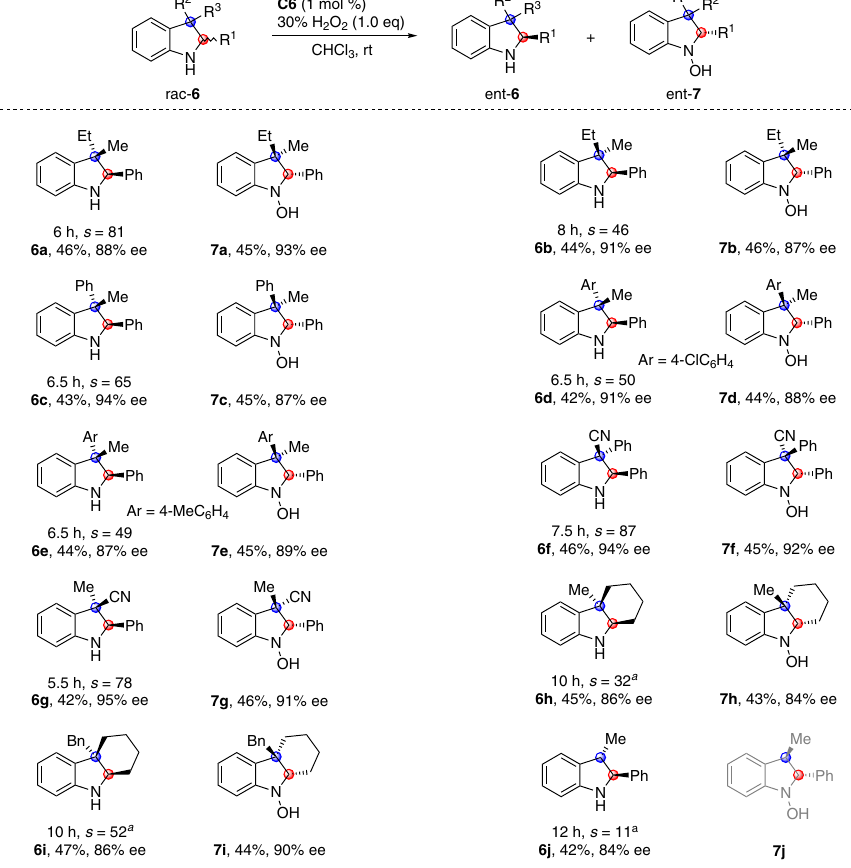
Fig. 4 Scope of indolines bearing two stereocenters. Conditions: rac- 6 (0.1 mmol), 30% aqueous H 2 O 2 (0.1 mmol), and C6 (1 mol %) in CHCl 3 (1.0 mL) at rt for indicated time period. a Reaction with 2.0 equiv of aqueous H 2 O 2 at 0